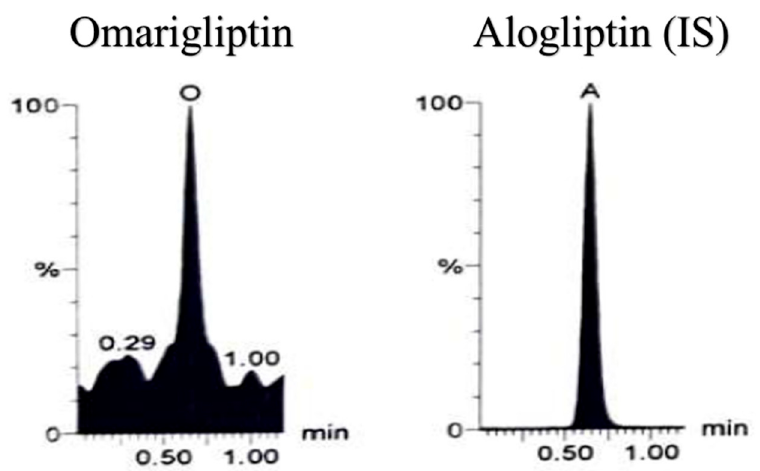
Figure 7. Lower limit of quantification (LLOQ) plasma sample using LC-MS / MS (25 nM of Omarigliptin) using Multiple reaction monitoring (MRM) chromatogram of omarigliptin ( m / z = 399.2 to 153.0) and alogliptin (IS, m / z = 340.2 to 116.0). Table 2. Accuracy and precision results for OTN determination by the proposed LC-MS / MS method. Accuracy and Precision (n = 5, Three